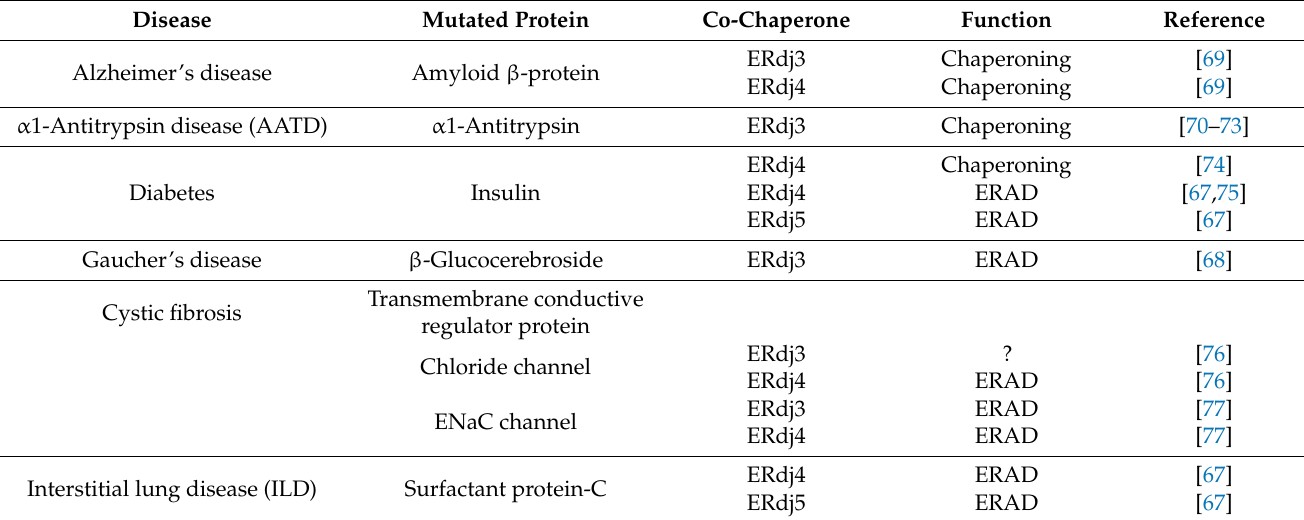
Table 1. Examples of co-chaperone functions in mutant proteins causing metabolic